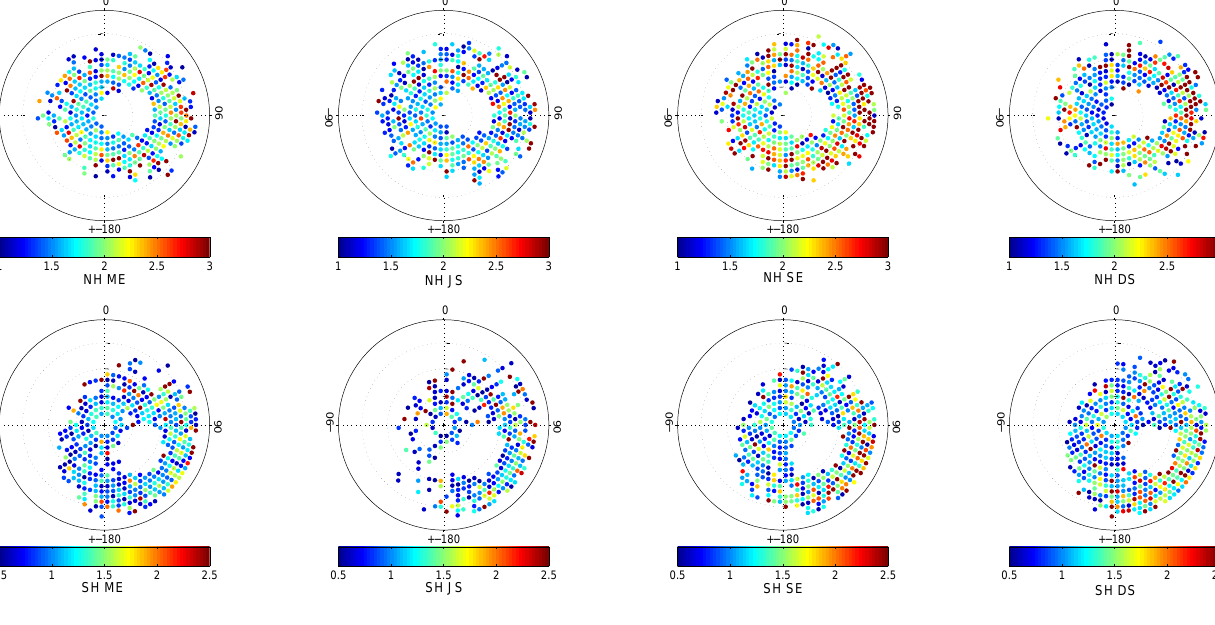
shown in Figure 5. An annual variation of the thermospheric density has earlier been deduced from satellite orbit analy- sis. For example, Boulton (1985) reported an air density in the altitude range 240-470 km that is 1.3 times larger in De- cember than in June. Up to date there is no consensus on the mechanism causing this major annual variation. As a viable candidate an atmospheric composition change is discussed